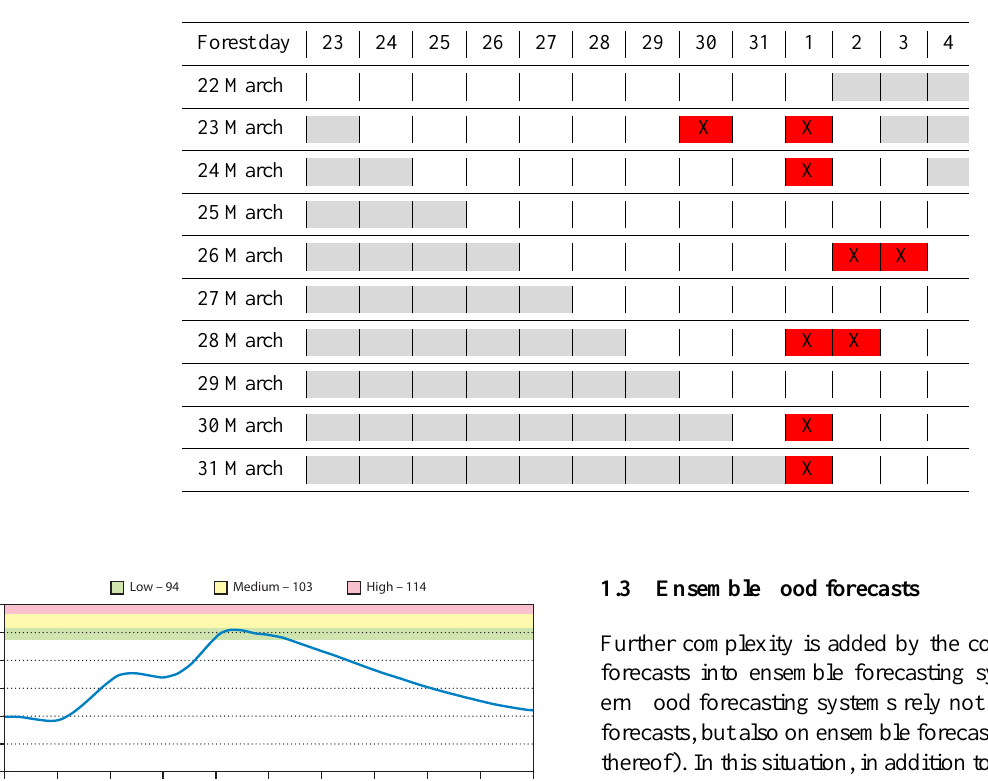
Table 1. Inconsistent threshold exceedance according to Fig. 1. The rows indicate the date and time that the forecast was issued and the columns indicate the date for which the forecast was issued.